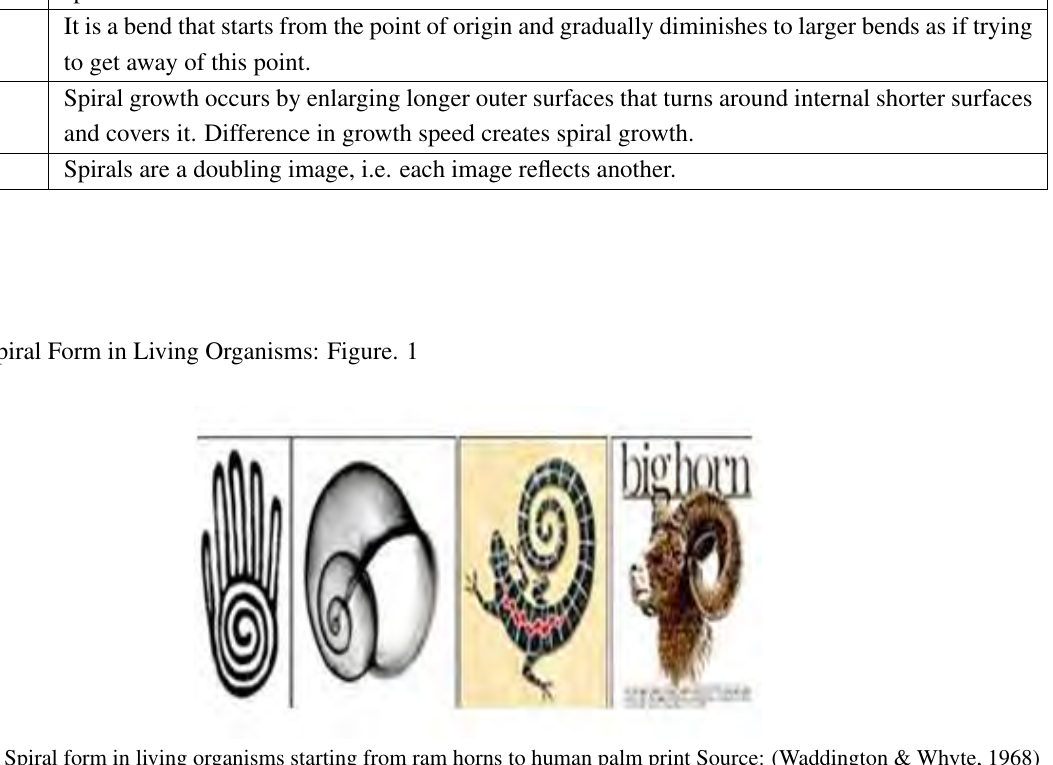
Figure 1. Spiral form in living organisms starting from ram horns to human palm print Source: (Waddington & Whyte, 1968) Snails grow by enlarging the outer surfaces faster away from rotation axis. Difference in growing speed creates the form of spire without using any other method (Feuerstein, 2002).